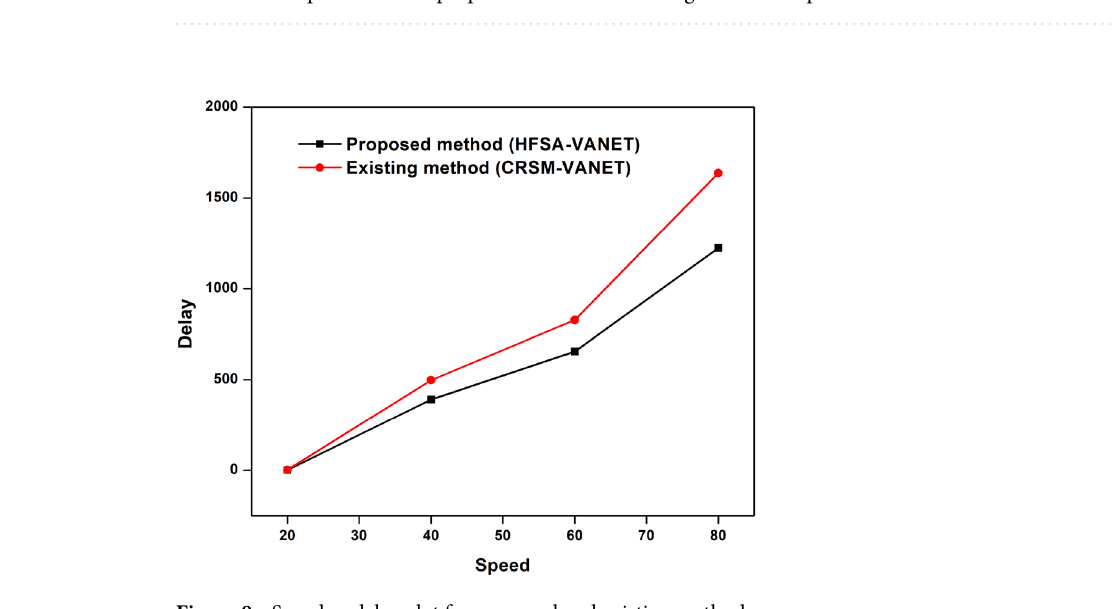
Figure 8. Speed vs delay plot for proposed and existing